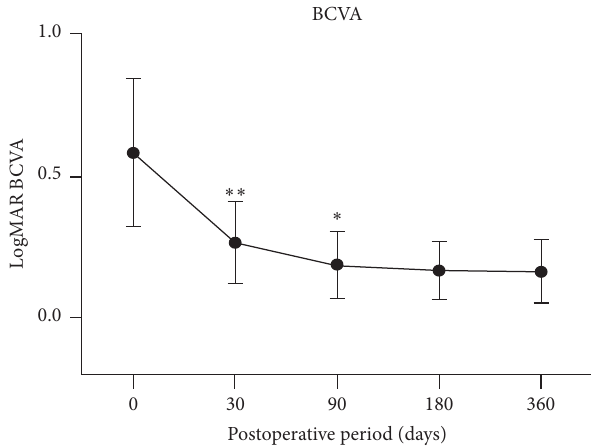
Figure 3: Graph showing the progressive postoperative im- provement of BCVA. Visual acuity largely increased at 1 month, further improved at 3 months, and remained stable until the end of follow-up.